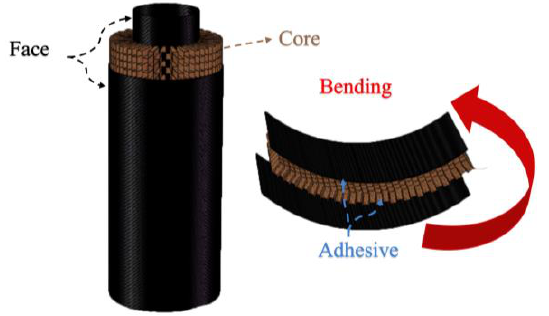
Figure 2. The components of the AHST.